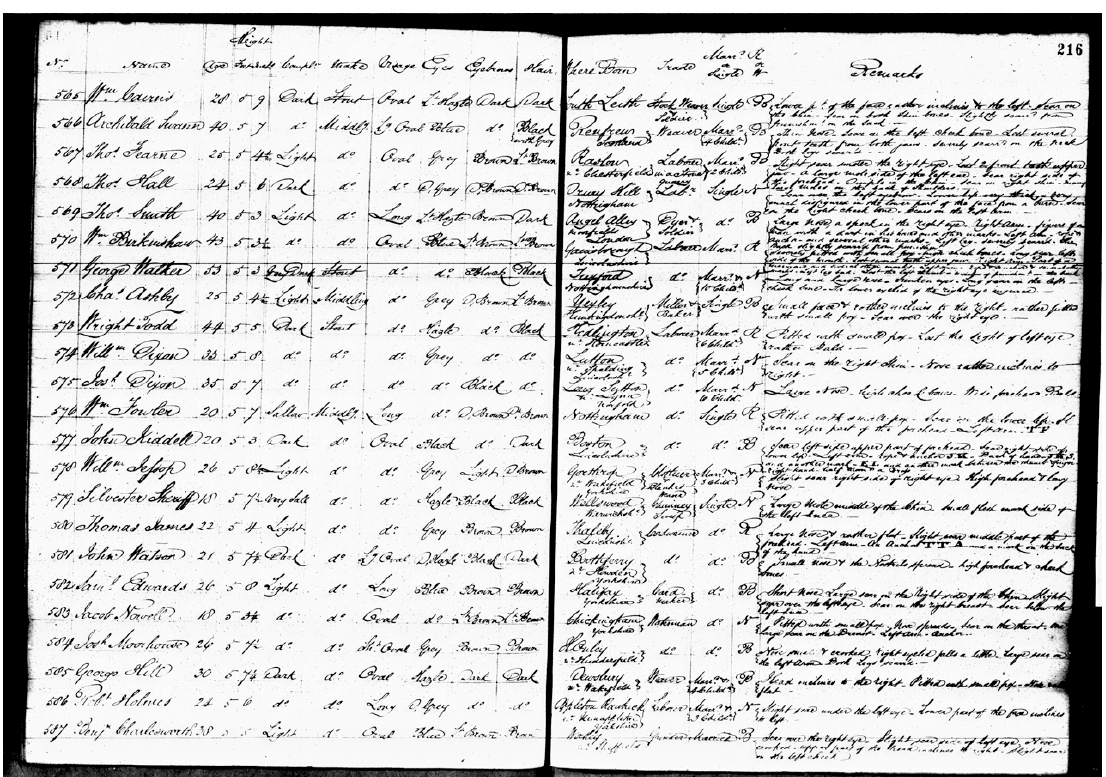
Figure 8. William Birkinshaw (no. 570).